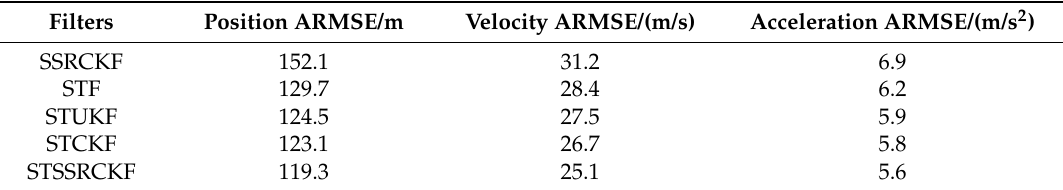
Table 1. Tracking performance comparison.